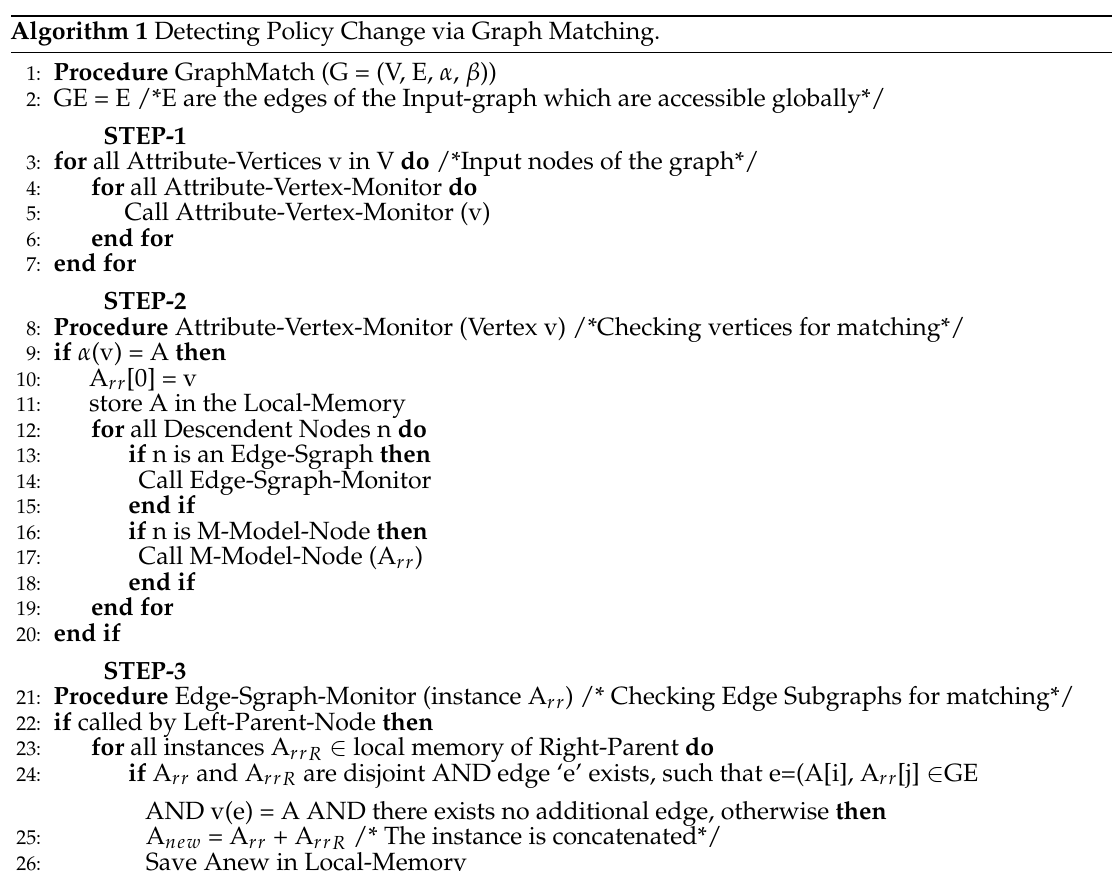
Algorithm 1 Detecting Policy Change via Graph